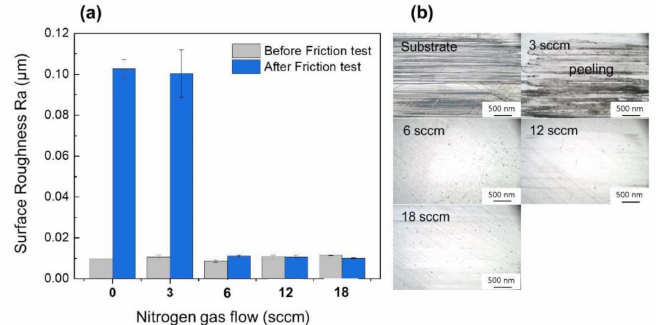
Figure 6. ( a ) Surface roughness values before and after friction tests and ( b ) optical microscopy images of the surfaces after friction